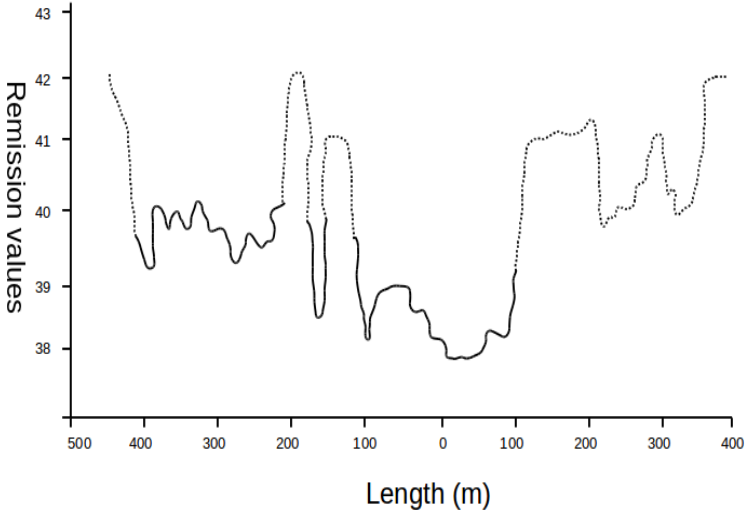
Figure 3. Reflection measurement for soil, weeds and maize. A continuous line (—) represents soil presence. A dotted line (- - -) represents vegetation presence. Fig.